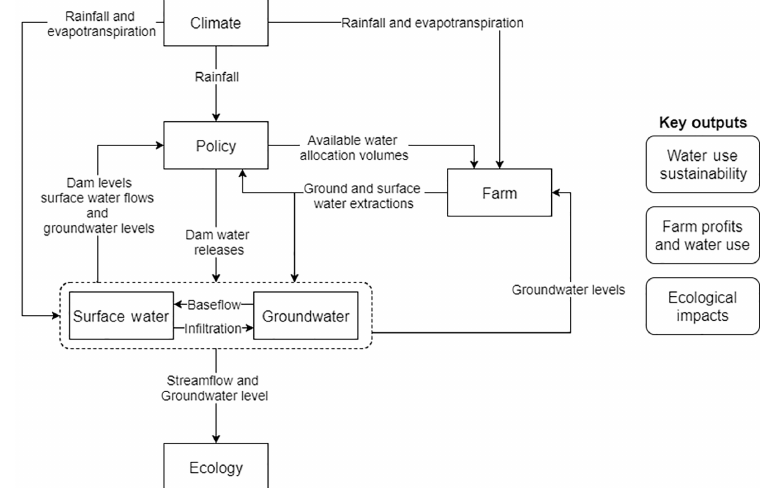
Figure 3. The interactions between component models and key model outputs. The dashed box around surface and groundwater models was inserted to simplify the model diagram and is not intended to indicate a separate coupled